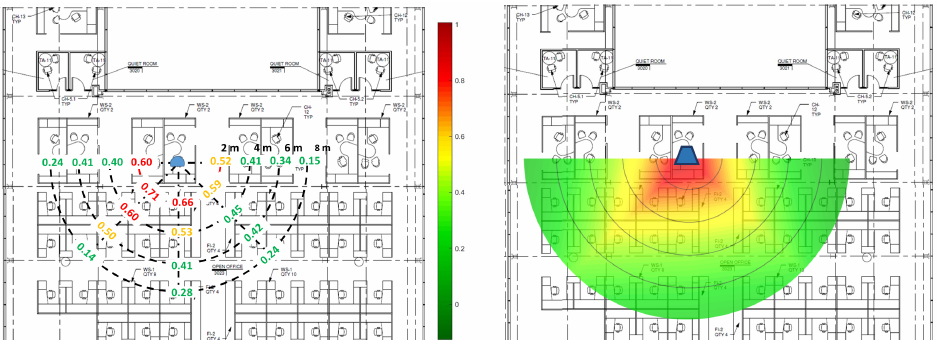
Figure 4. Acoustic comfort mapping with STI of north-facing workstation at the LEED building with the speaker in sitting position and sound masking on. ( Left ) Scaled drawing depicting STI measurements at various location and distances. ( Right ) Associated surface plot highlighting areas from good to bad STI rating.